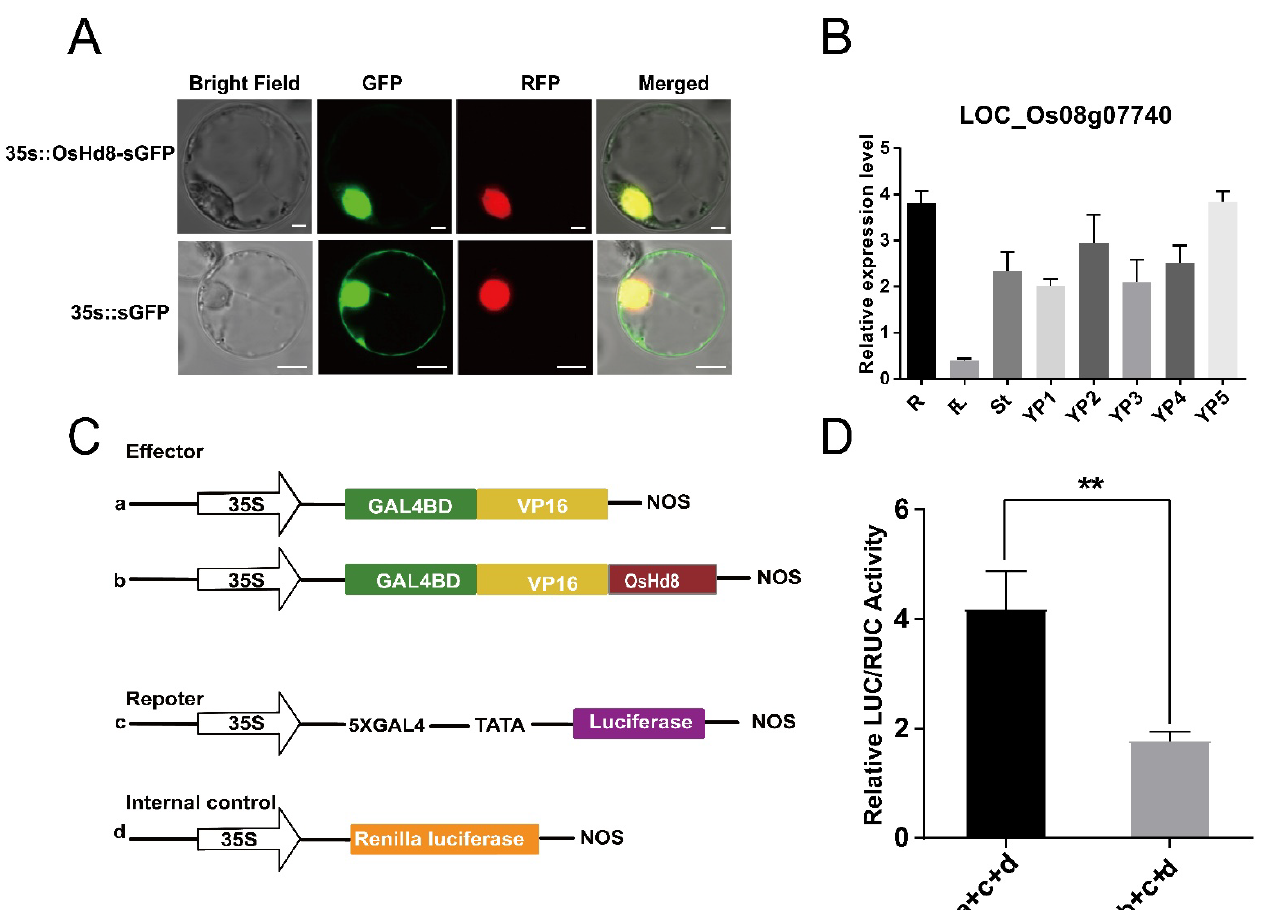
Figure 4. Molecular characterization of OsHd8 . ( A ) Subcellular localization of OsHd8 (35S:: OsHd8- sGFP) in rice protoplasts. Scale bar = 10 μm; ( B ) OsHd8 expression levels in various organs revealed by qRT–PCR, including roots (R), Flag leaf (FL), stem node (St) and young panicles of different lengths (YP1: 0.5-1 cm young panicle, YP2: 1-2 cm young panicle, YP3: 2-3 cm young panicle, YP4: 3-4 cm young panicle, YP5: 4-5 cm young panicle). Values are means ± SEM (n = 3), ** indicates a significant difference at p < 0.01 by t -test; ( C ) The main structure of vectors of transcriptional activity assays; ( D